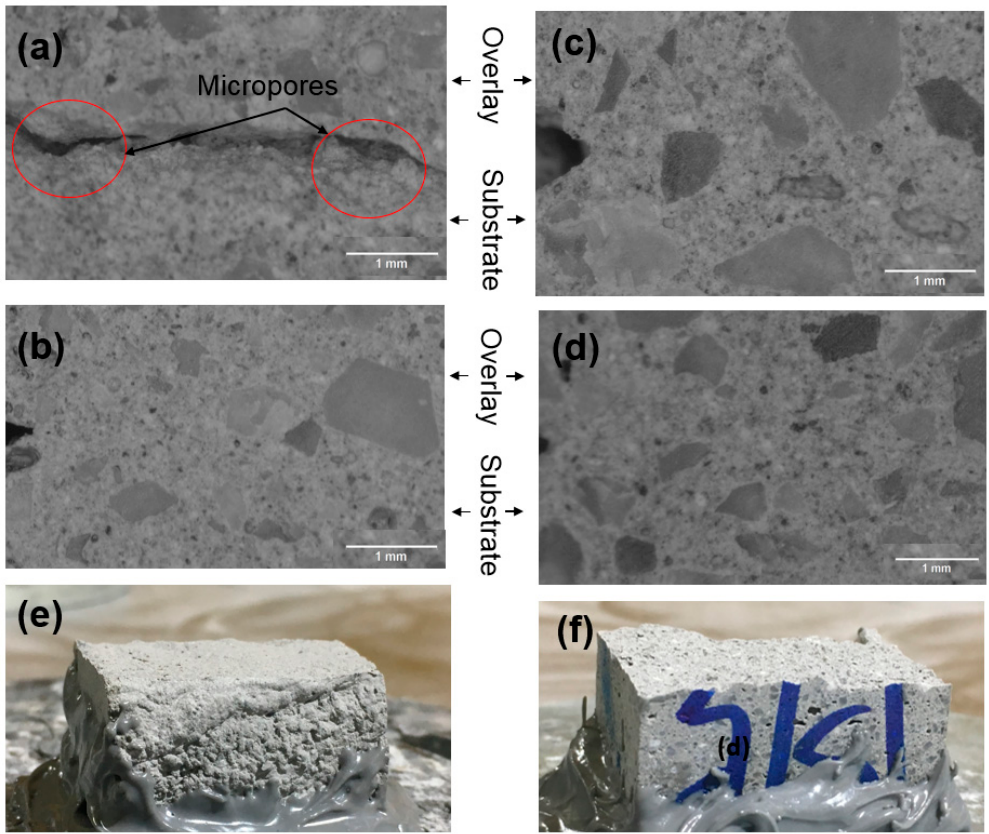
Figure 6. Optical microscopic images of NM mix interface for ( a ) 20 mm ( b ) 15 mm SD; Interface of CM mixture for ( c ) 20 mm and ( d ) 15 mm SD; fracture surfaces of ( e ) NM ( f ) CM mixtures for 20 mm SD.